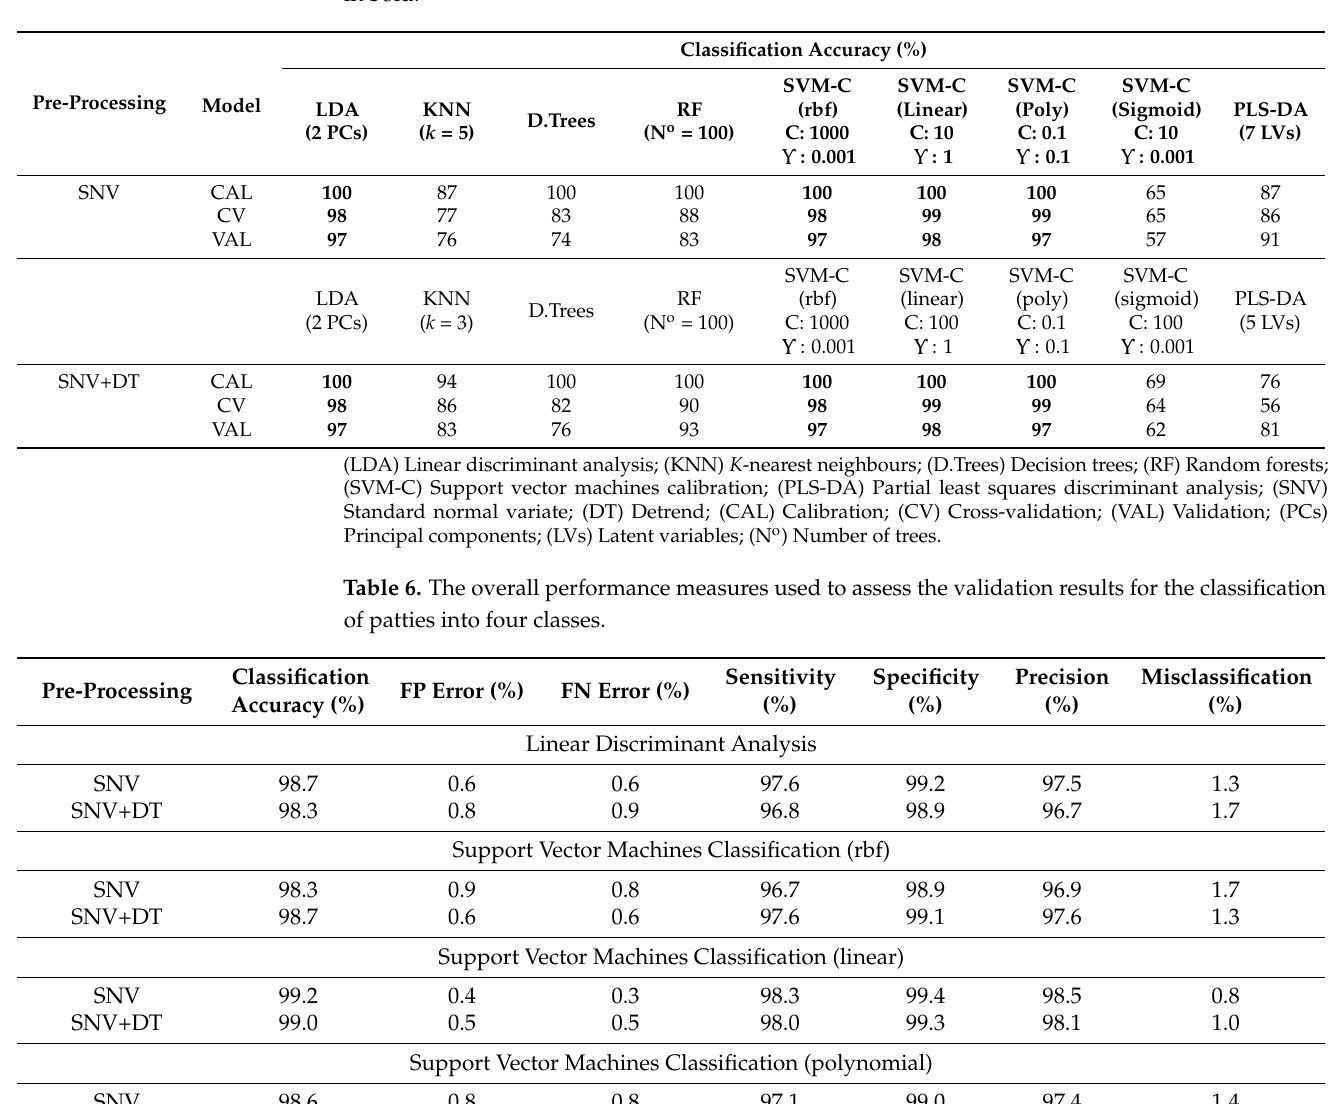
Table 6. The overall performance measures used to assess the validation results for the classification of patties into four classes.